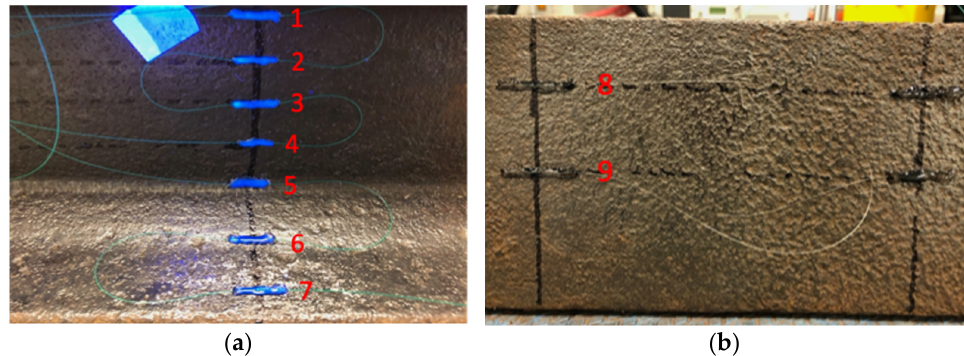
Figure 5 . Pictures of the FBG placement: ( a ) On the web (1-5) and on the foot (6-7); ( b ) Under the foot (8-9).